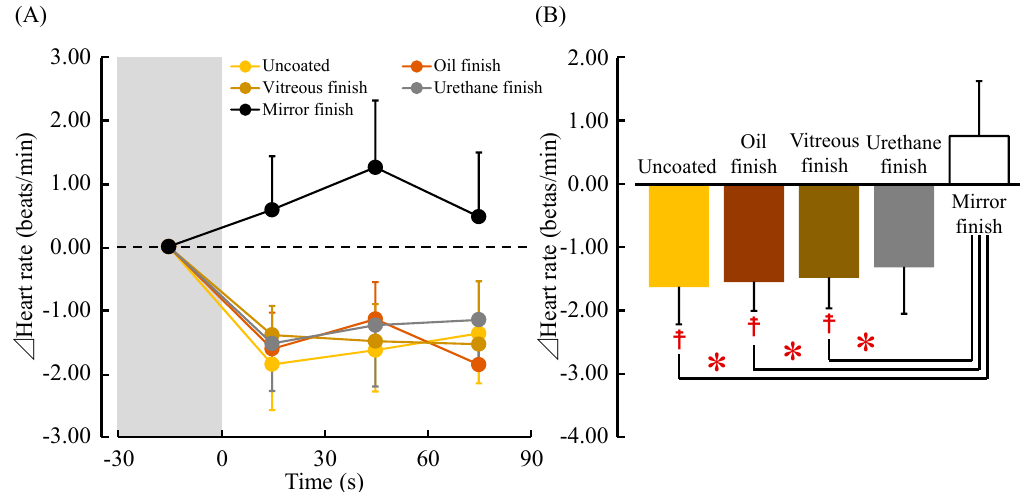
Figure 7. Thirty-second averages and overall mean heart rate while touching white oak wood (uncoated, oil finish, vitreous finish, urethane finish, and mirror finish). ( A ) Changes in each 30-s average heart rate over 90 s; ( B ) Overall mean HF values. Data are expressed as the mean ± standard error, n = 18, ☨ p < 0.05 (comparing pre- vs. post-measurement values), * p < 0.05 (comparing the five samples) as determined by the paired t- test; Holm correction was applied.